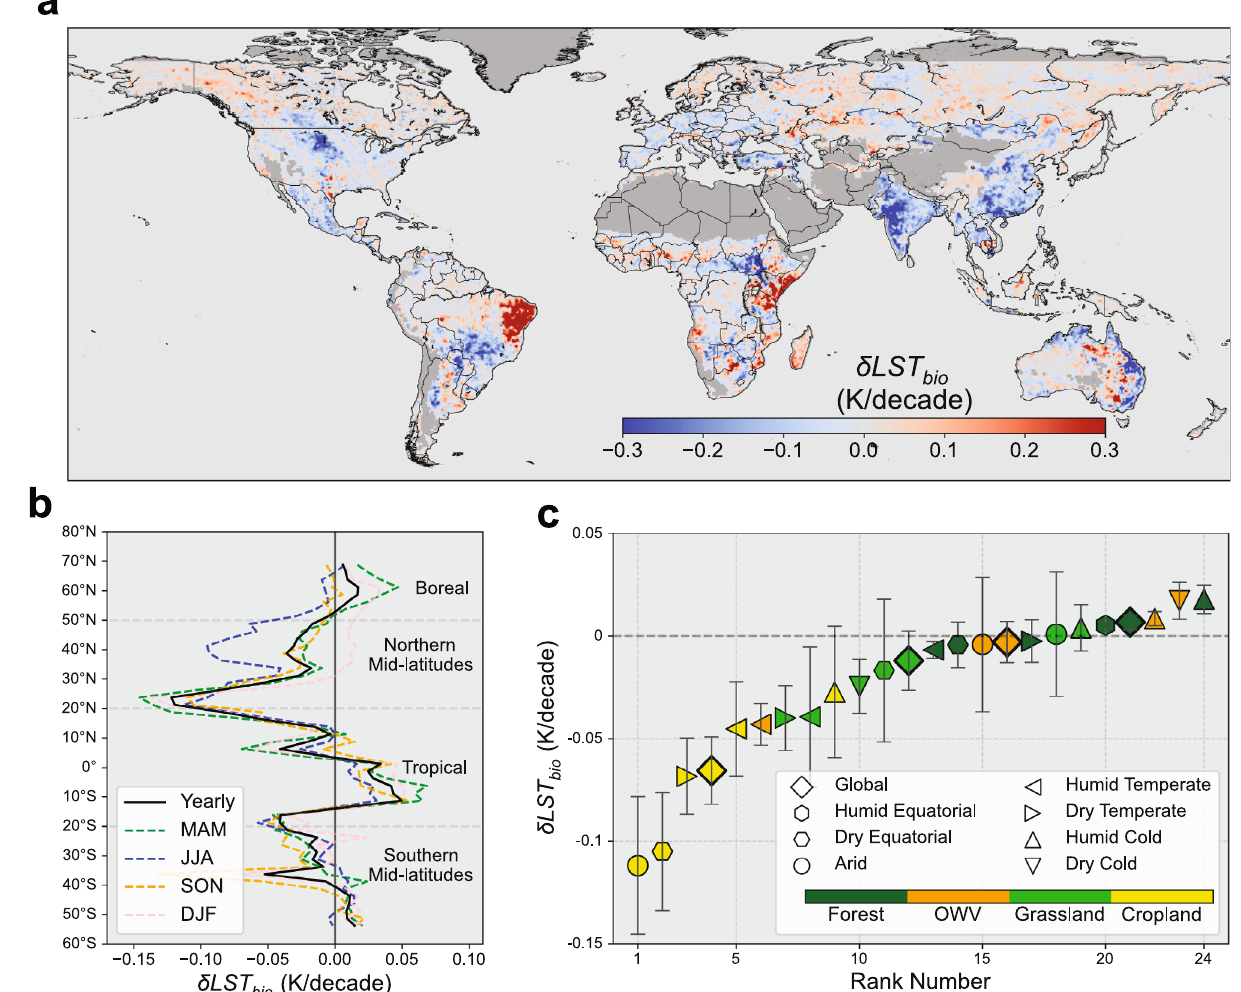
Fig.5|Thelandsurfacetemperaturetrendinducedbybiophysicalfeedbackof earth greening ( δ LST bio ) over 2001 – 2018. a Global map of δ LST bio . b Latitudinal meansofannualandseasonal δ LST bio .Abbreviations:MAM,MarchtoMay;JJA,June toAugust;SON,SeptembertoNovember;DJF,DecembertoFebruary. c